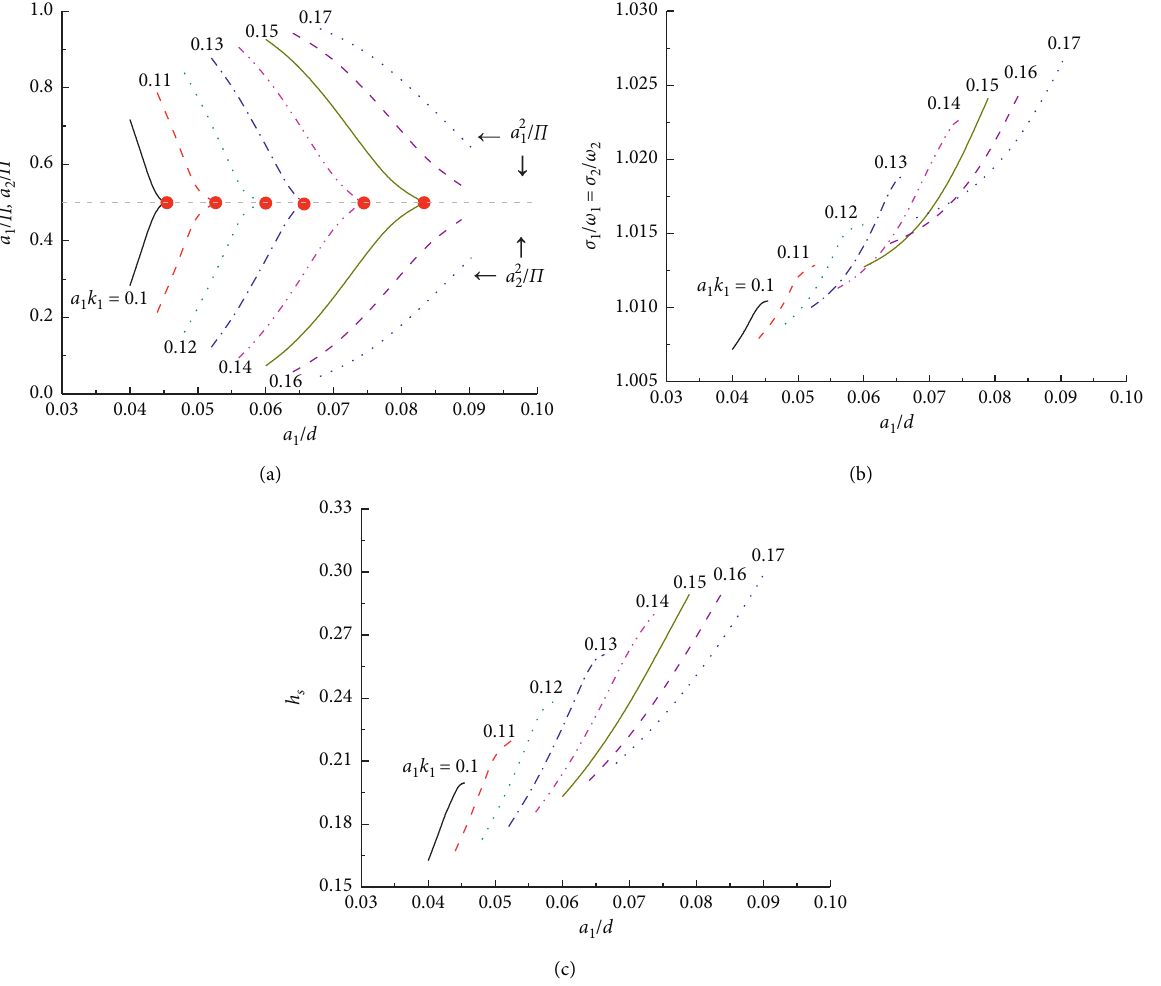
) and resonant wave components ( σ / ω 1 1 � 0.15, α � 3 π /8, and δω � 0. (a) Wave 1